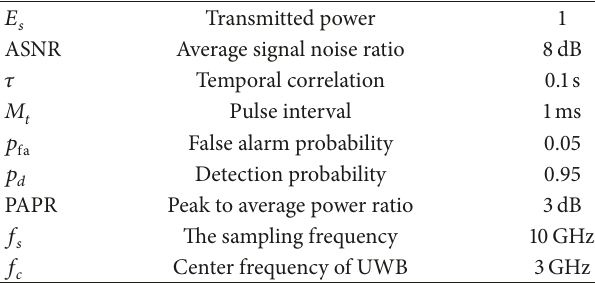
Table 1: Simulation parameters